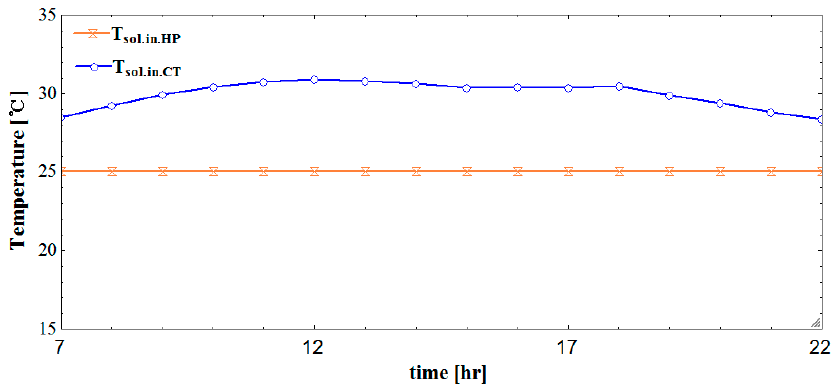
Figure 8. Absorber inlet temperatures of desiccant solution on the peak cooling day.